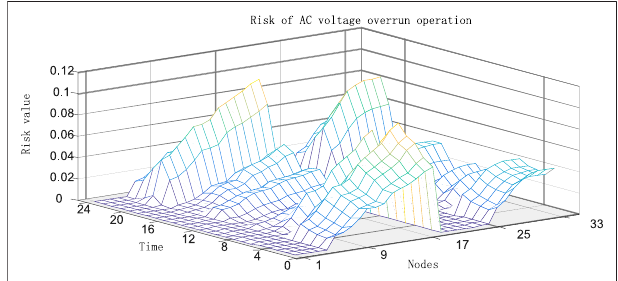
FIGURE 8 | Risk of over-voltage operation of AC distribution network